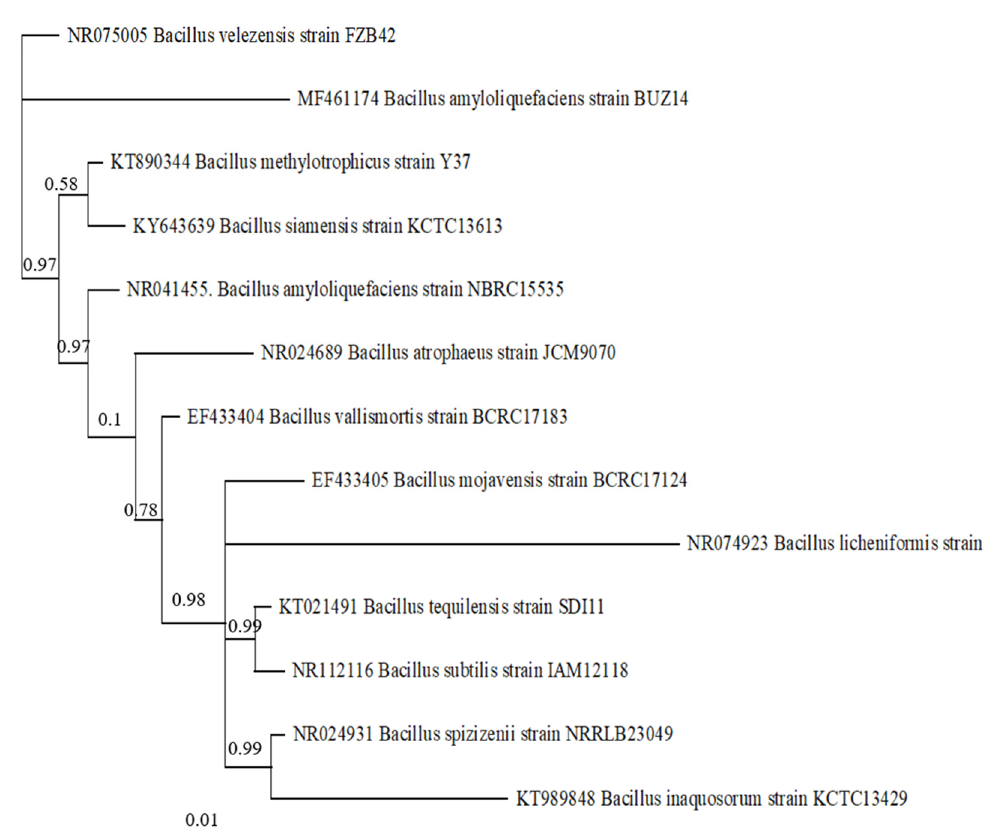
Figure A1. The Bayesian 50% majority-rule consensus tree obtained after 2,000,000 generations, inferred from the ribosomal 16S sequence of B. velezensis strain BUZ14 and allied Bacillus species. The numbers above nodes represent Bayesian posterior probabilities. Only nodes significantly supported bear values. GenBank accession numbers are indicated next to the specific epithets.